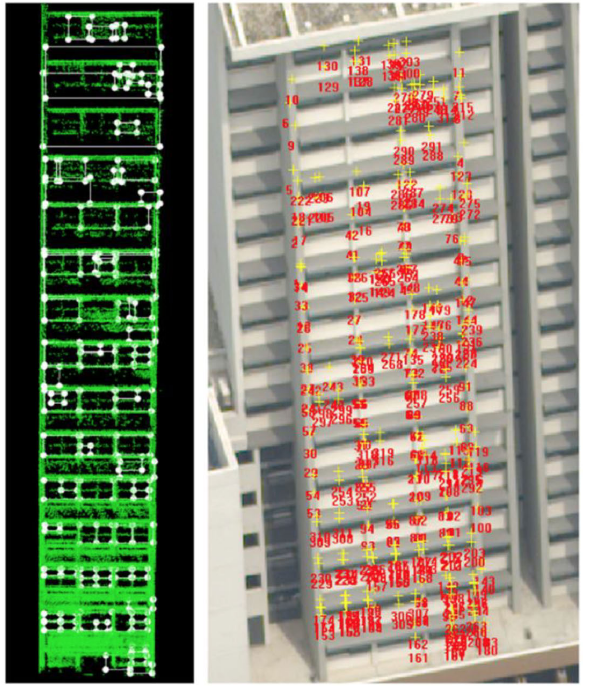
Figure 9. Reprojection of extracted feature points from the 3D point cloud to a 2D oblique Image; Left: The green colour represents the inhomogeneous mobile LiDAR data of a fac¸ade. White dots are the extracted feature points; Right: yellow points are the reprojected points from the white dots. Numbers show the topology of the points Figure 10. The fac¸ade texture extraction procedure from oblique